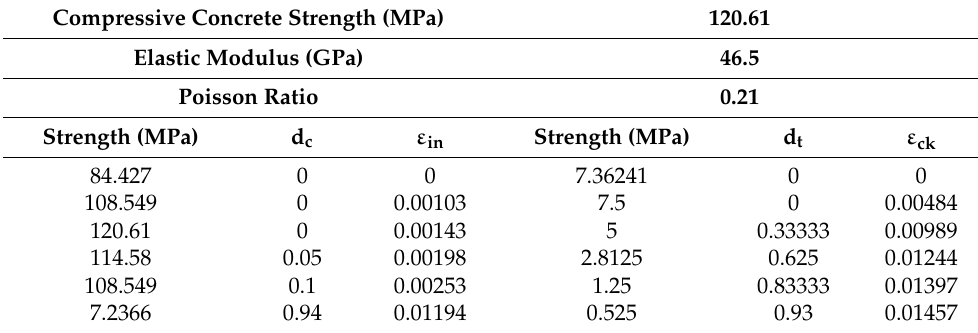
Table 5. Properties of UHPFRC along with CDP model parameters in compression and tension in the shear